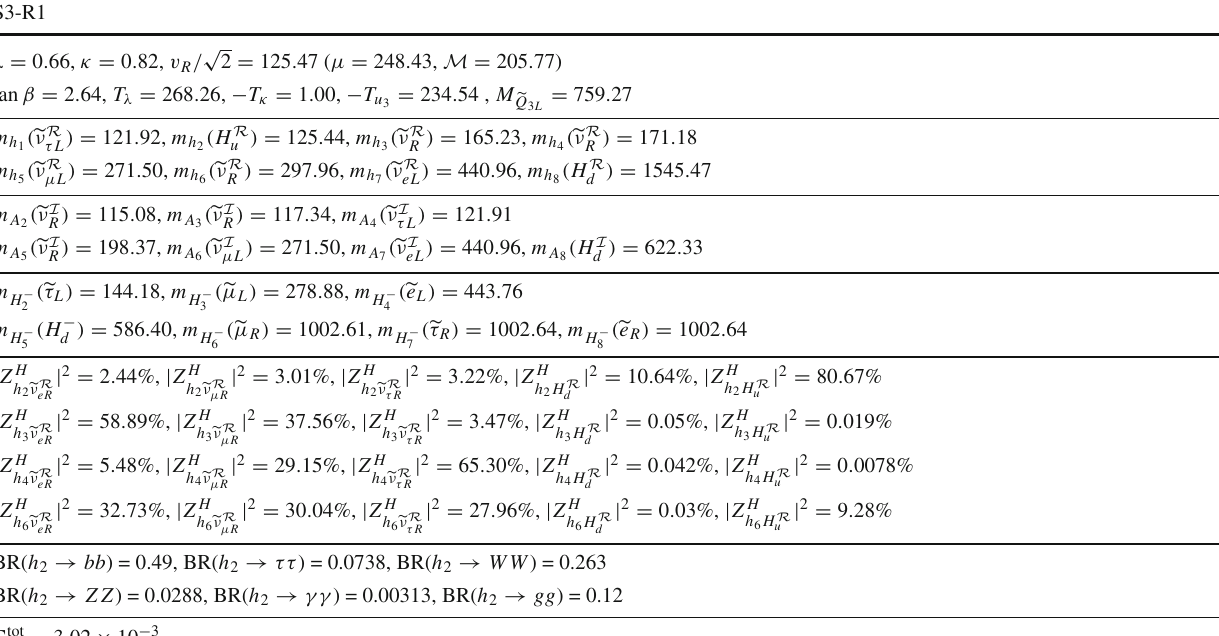
Table 12 Benchmark point S3-R1 from scan S 3 , with the SM-like associating the first doscalars by A 2 ,..., 8 and charged Higgses by H − 2 ,..., 8 Higgs h 2 being the lightest scalar. Input parameters at the low scale states to the Goldstone bosons eaten by the Z and W ± . Their dominant M EWSB are given in the first box, where we also show for complete- √ √ composition is written in brackets. For the case of the SM-like Higgs ness μ = 3 λv R / 2 and M = 2 κv R / 2 since their values deter- and singlet-like scalars their main compositions are broken down in the mine Higgsino and right-handed neutrino masses. Scalar, pseudoscalar fifth box. Relevant branching ratios for the SM-like Higgs h 2 are shown and charged Higgs masses are shown in the second, third and fourth in the sixth box. Its decay width is shown in the seventh box. VEVs, boxes,respectively.Scalarmasseigenstatesaredenotedby h 1 ,..., 8 ,pseu- soft parameters, sparticle masses and decay widths are given in